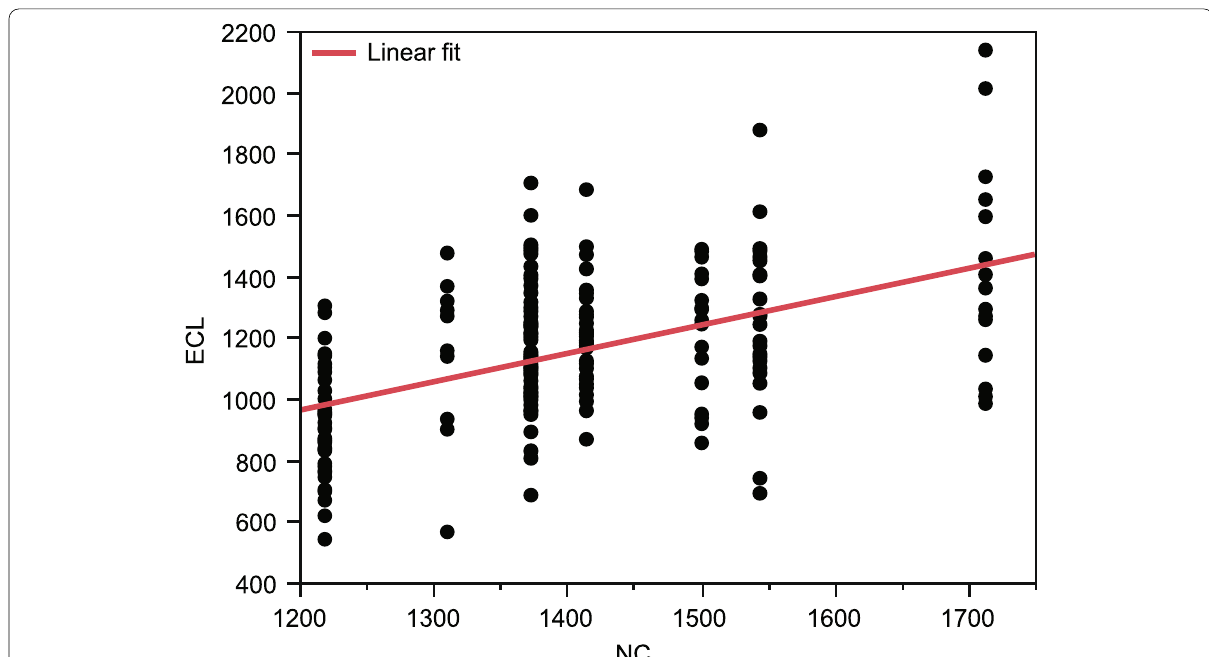
Fig. 5 Evaluation of human serum ECL values by corresponding negative control, excluding high CV samples, voided samples, and outliers. Linear fit: ECL 147.9245 0.9242683 NC. ECL, electrochemiluminescence; NC, negative = − + ×